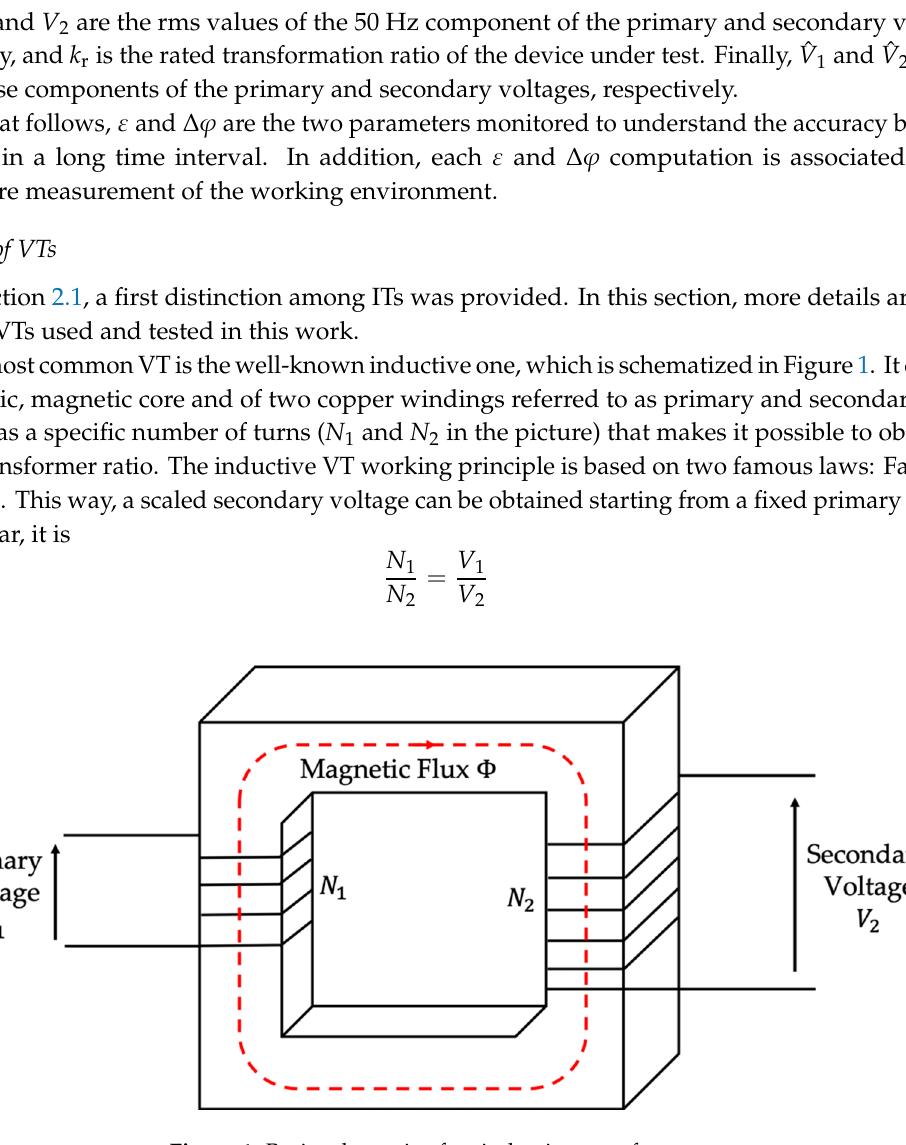
Figure 1. Basic schematic of an inductive transformer.